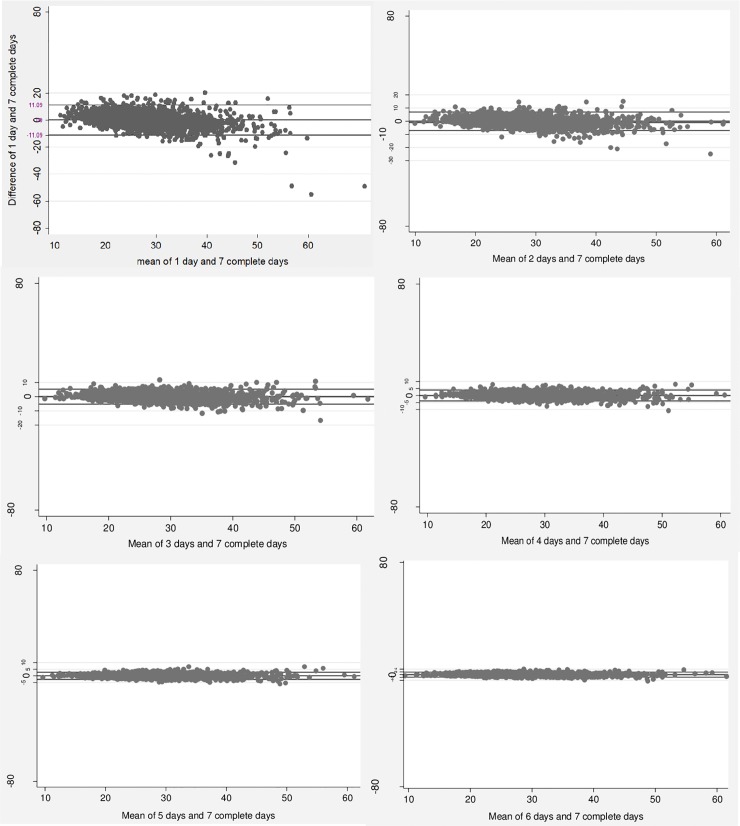
Bland-Altman plots of the comparison between the means of measurement days (1 to 6) and the standard of seven complete days of measurement for overall physical activity.